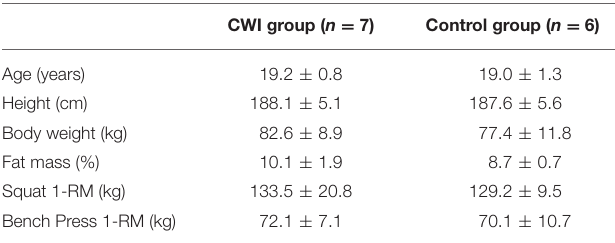
TABLE 1 | Participant characteristics.